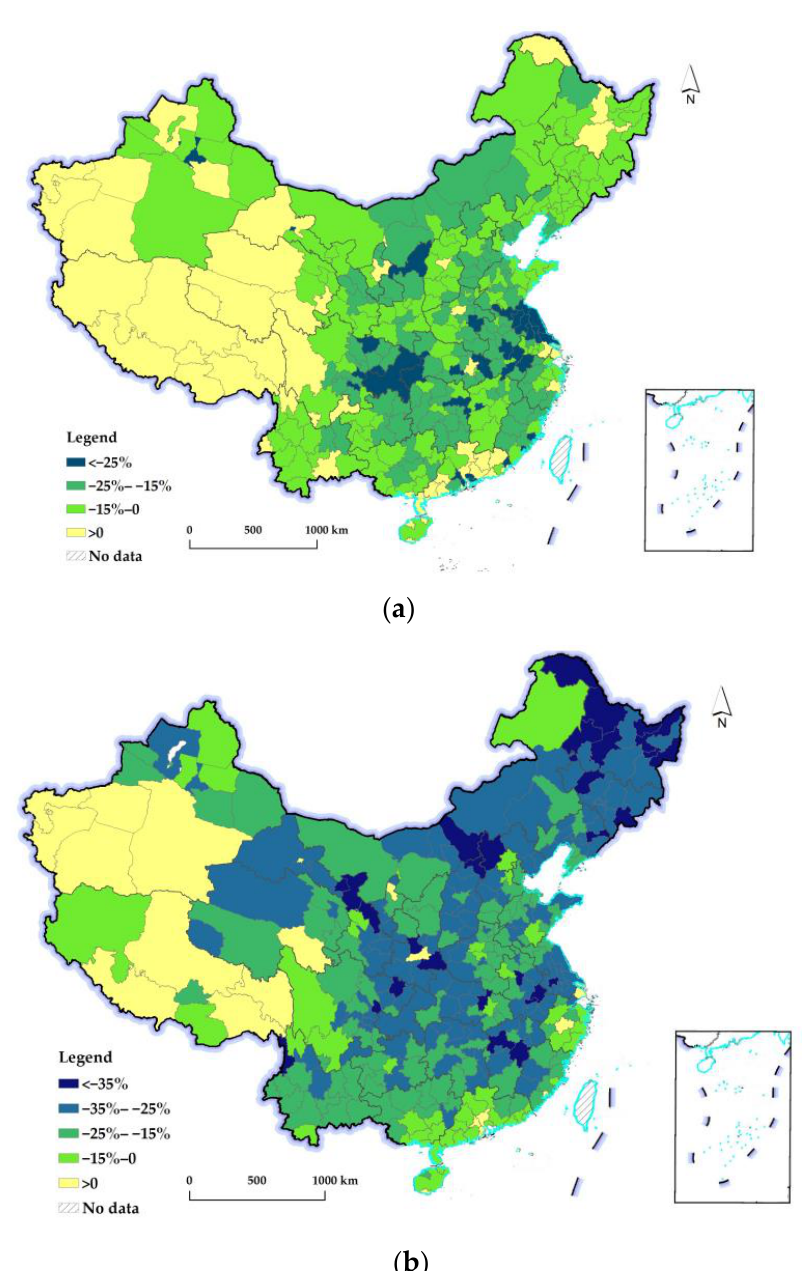
Figure 5. The changes in rural population density from 2000 to 2020. ( a ) 2000 – 2010; ( b ) 2010 – 2020. The results of the hot-spot analysis are presented in Figure 6. Most of the units in the coastal, central, and western regions formed cold spots from 2000 to 2010, indicating that these units had a significantly higher decline rate in the rural population. Meanwhile, the hotspots were concentrated in the northeast region, Tibet, and part of Qinghai. There were some changes from 2010 to 2020. The cold spots formed two concentration regions: one contained the units in the MYR, Cheng-Yu, and northwest regions, and the other mainly referred to the northeast region. In contrast, most units in coastal regions became insignificant. The units in Tibet were still hot spots, and most units in Guangdong, Guangxi, Fujian, and Jiangxi changed from insignificant to hot